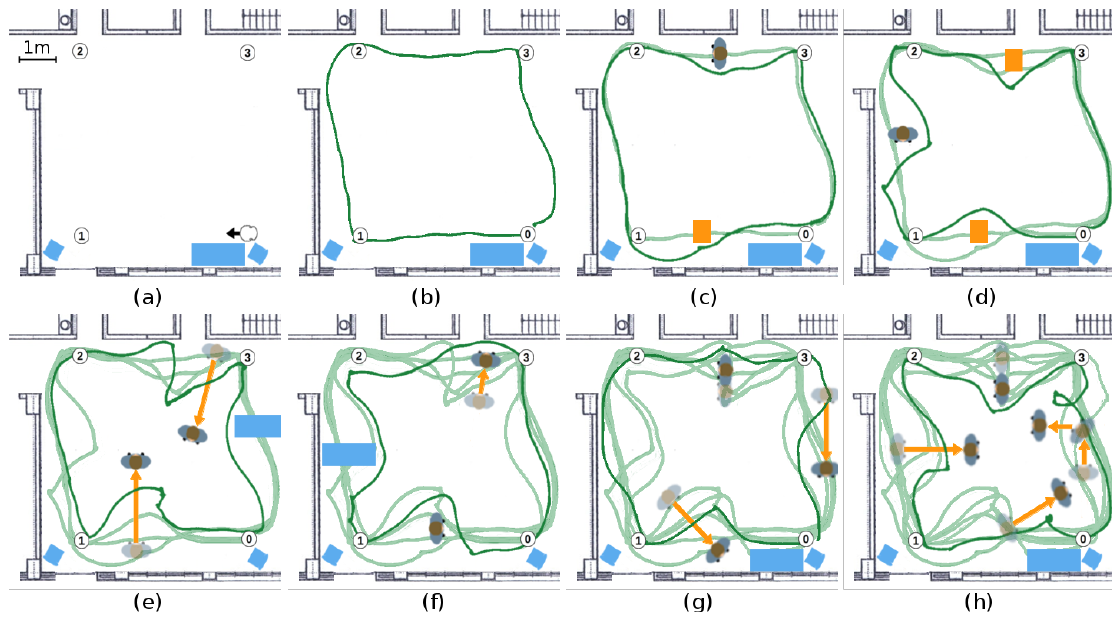
Figure 8. Results in the dynamic environment. The green path depicts the robot’s movements from odometry data. Blue shapes depict obstacles already in the scene, and orange shapes depict newly introduced obstacles. A human obstacle was introduced in the scene, and if it was in motion, its opaque shape designated the starting position of the motion. The motion direction is visualized by an orange arrow. Numbers from 0 to 3 describe the locations and sequence of the target goals. ( a ) Layout of the experiment environment. ( b ) Experiment without obstacles. ( c , d ) Experiments with new static obstacles. ( e , f ) Experiments with relocated static and dynamic human obstacles. ( g , h ) Experiments with dynamic human